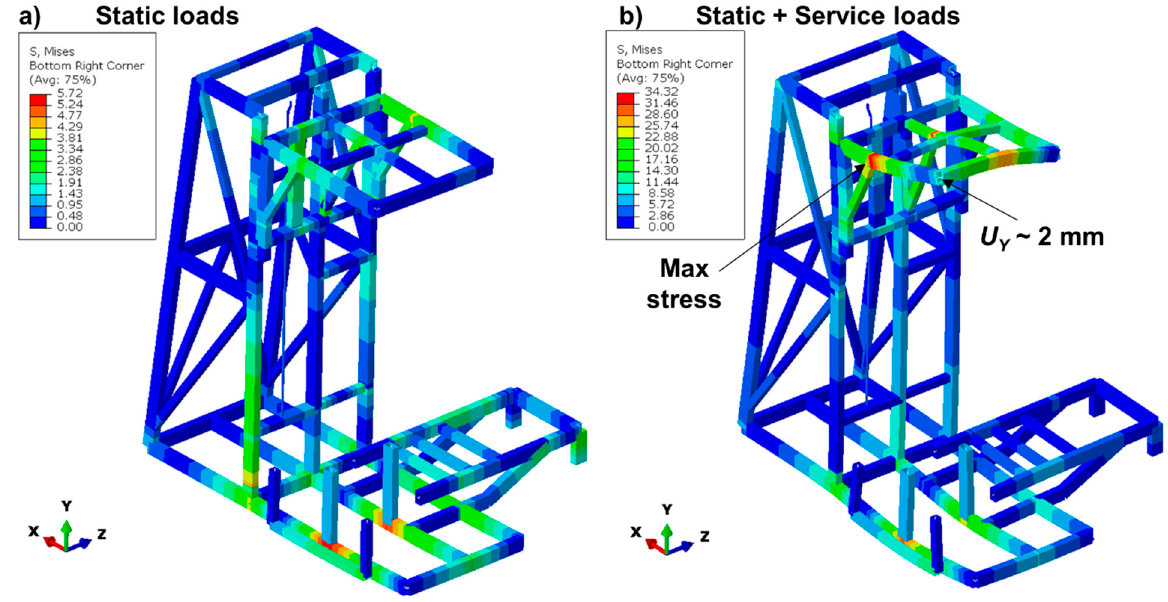
Figure 5. Contour plots of von Mises equivalent stress for ( a ) static and ( b ) service loading conditions; 1D elements shown through a 3D rendering with a scale factor equal to 0.5 to improve visibility; scale factor for deformations equal to 250; units in MPa.